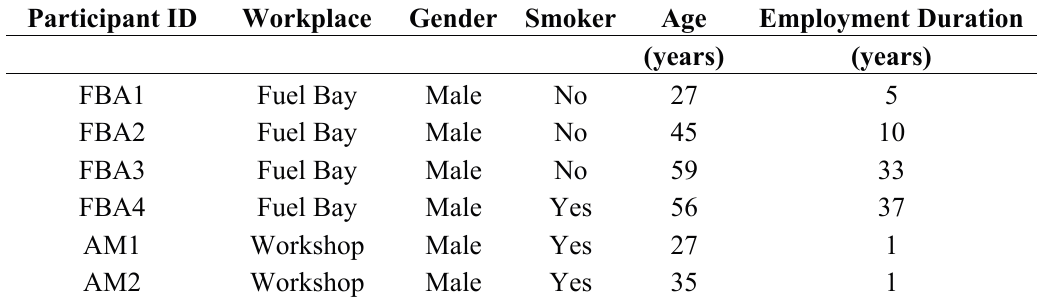
Table 2. Demographic data of participants in the fuel bay attendants (FBA) and auto-mechanics (AM). Data supplied by bus operating